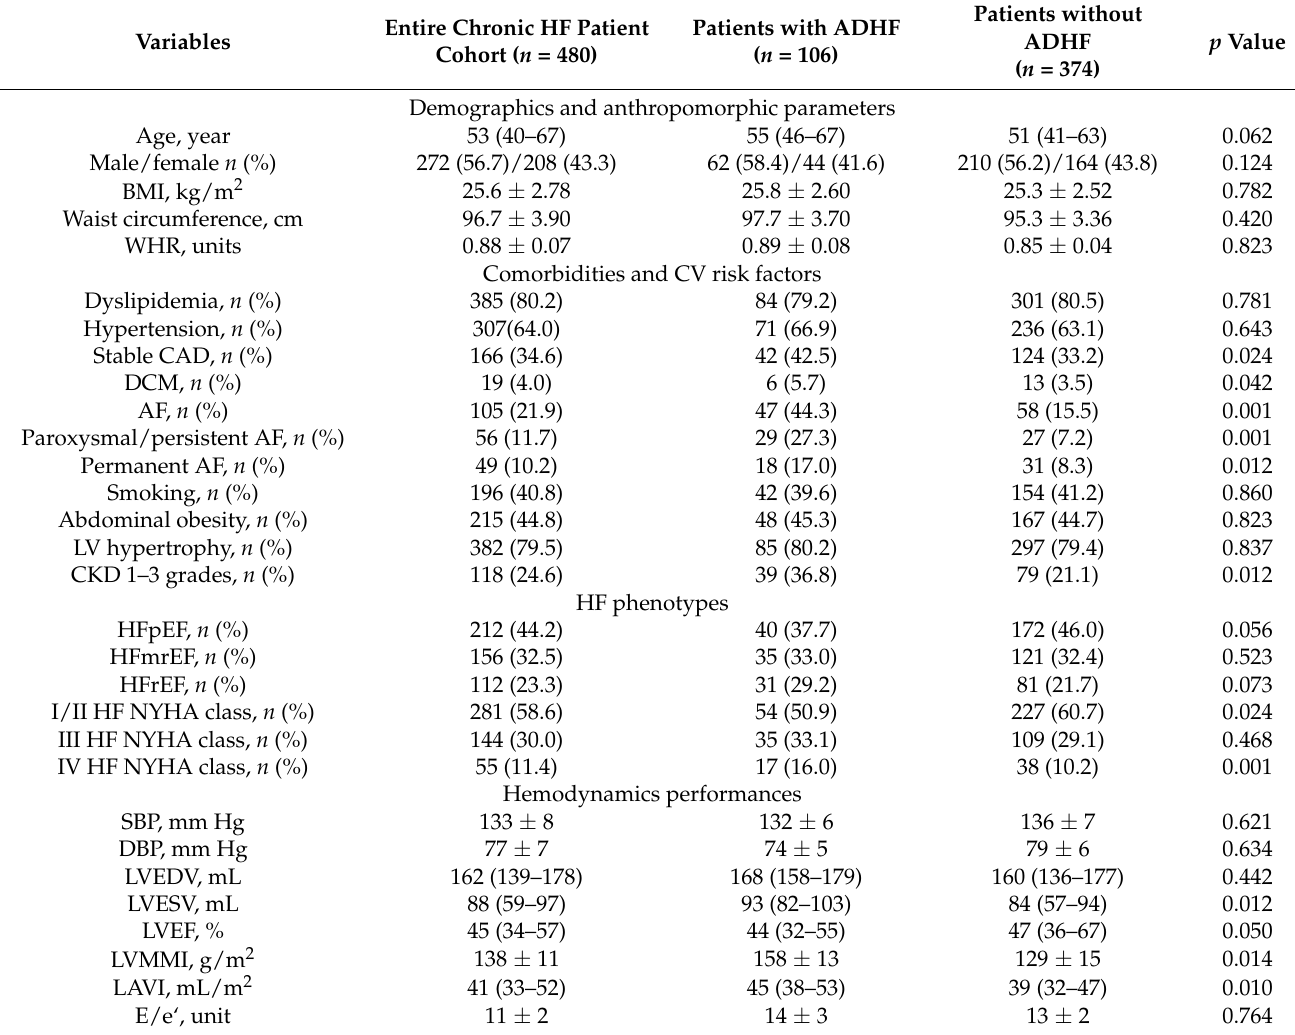
Table 1. Baseline general characteristics of eligible HF